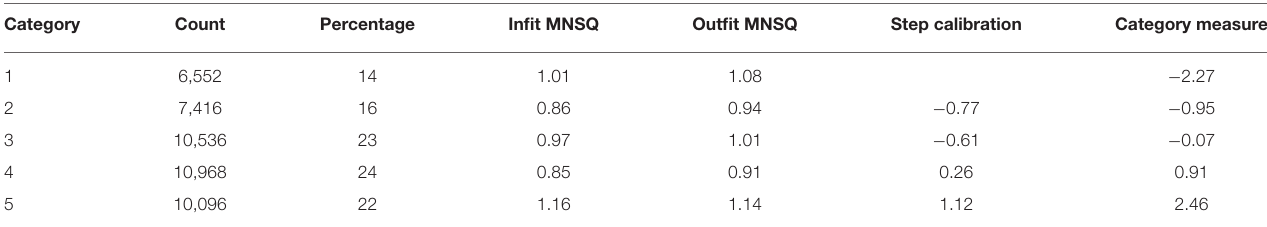
TABLE 6 | Rating scale category fit